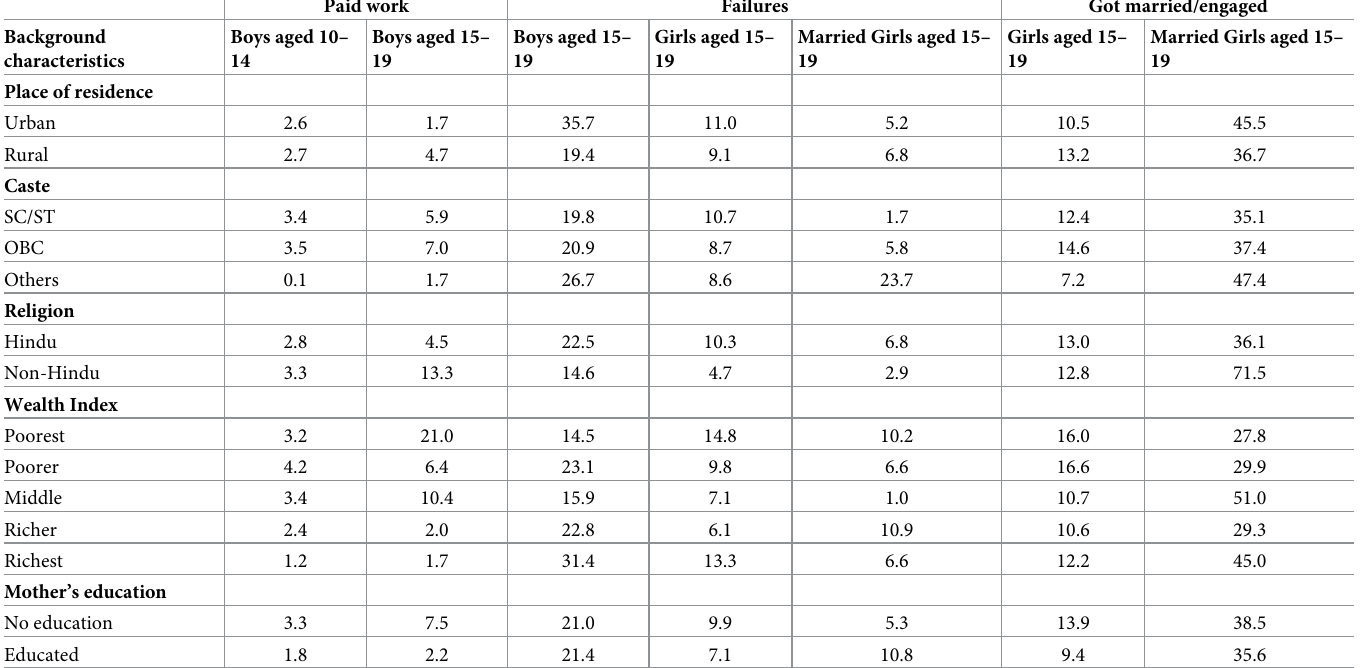
Table 6. Reasons for dropout among adolescents by socio-demographic and economic characteristics,